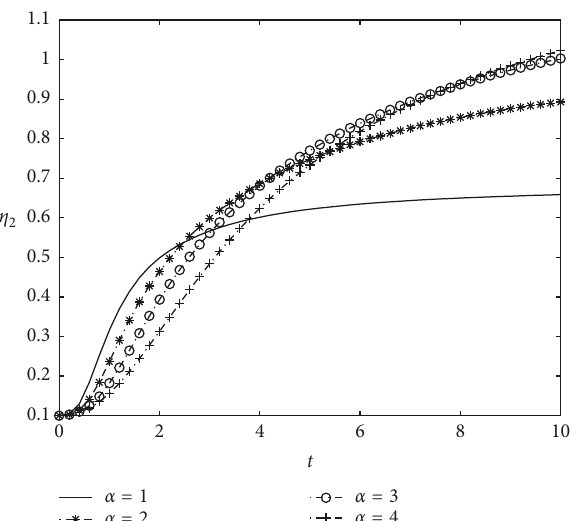
Figure 4: η over time for various values of α when applying the 2 first nonlinear adaptive